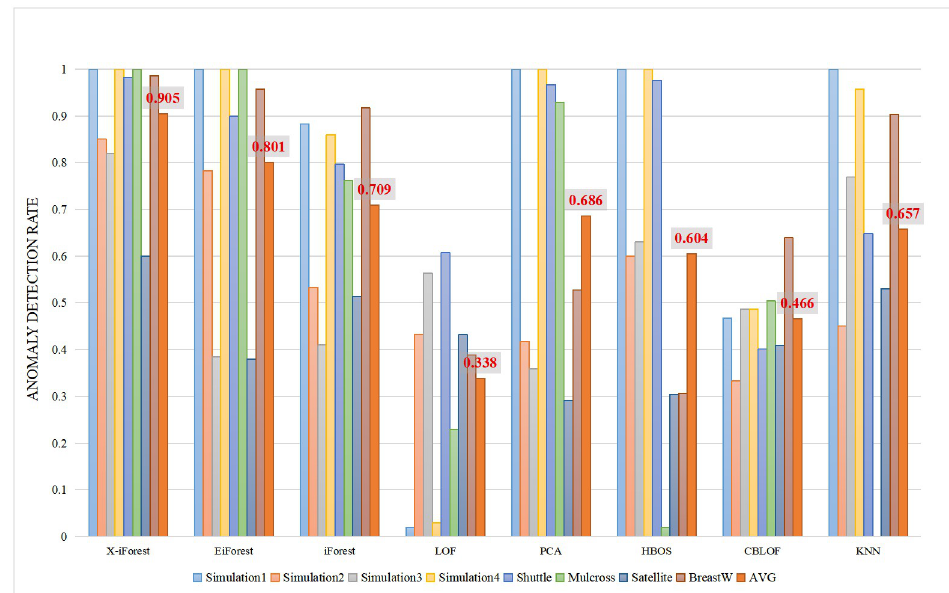
Fig 4. The ADR results of the proposed algorithm X-iForest and others